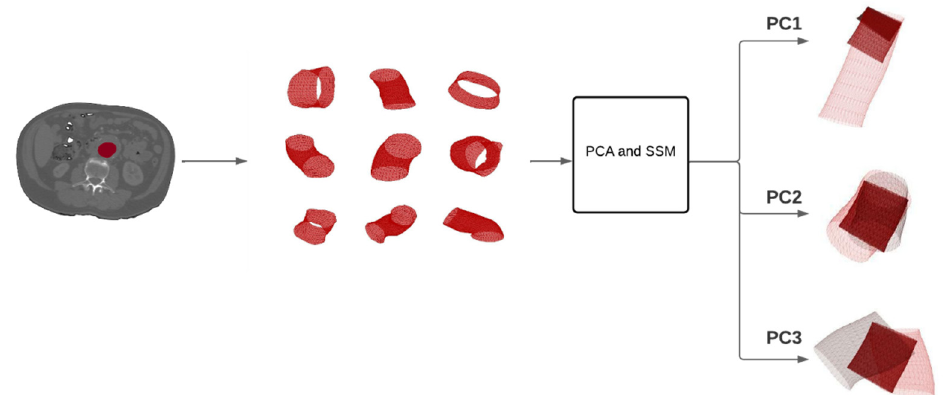
Figure 2. Workflow of the process from a CT scan to the principal component analysis (PCA) and statistical shape model (SSM) results. The first step is to segment the aortic neck lumen in the CT scan (red segmentation). Nine random samples, taken from the dataset consisting of 97 patients, are displayed in the second box to show the anatomical variation. The third box represents the mathe- matical procedures applied to perform a PCA and obtain the SSM. On the right, three visualizations, corresponding to the first three PCs, with the results of the SSM, are shown.